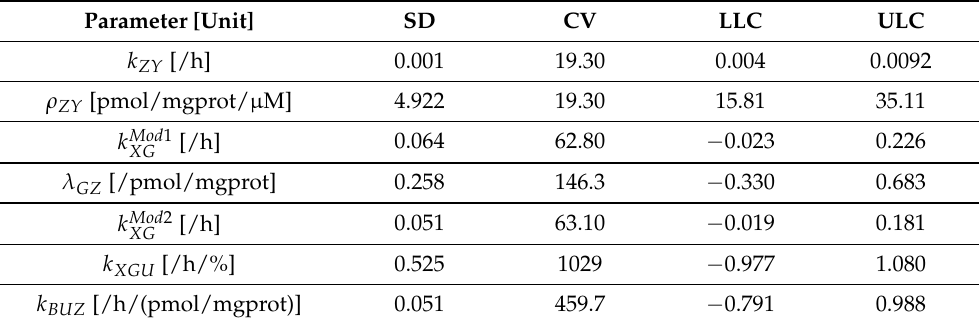
Table 5. Summary of the standard deviation (SD), percent coefficient of variation (CV), and lower and upper confidence limits for the zoledronate kinetic model and IPP antigen dynamics sub-model (Model 1 and Model 2) parameters. Because the parameter k XG is present in both models, the notation k Mod 1 and k Mod 2 was used in the Table to differentiate XG XG